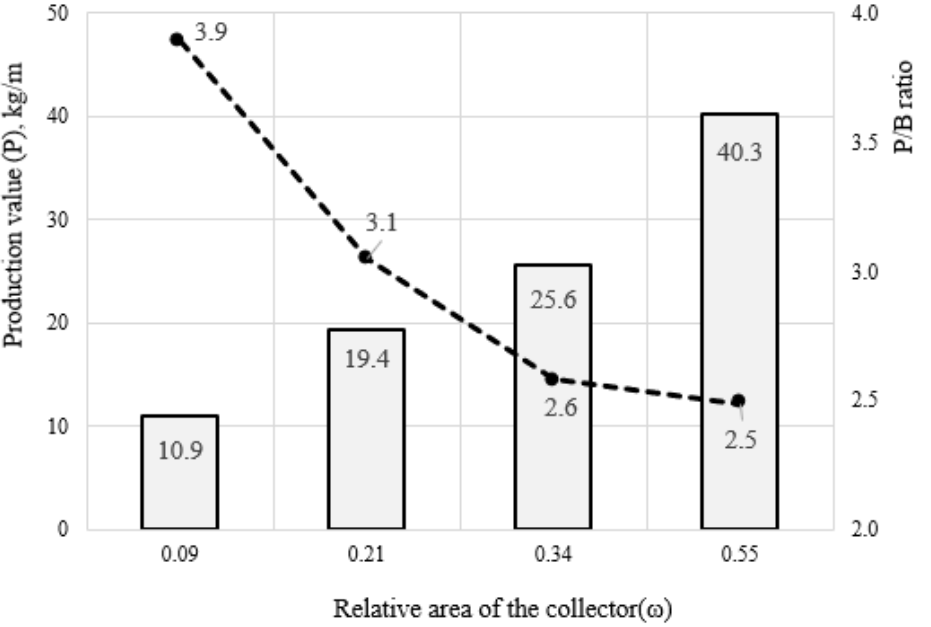
Figure 7. Change in the average production value (P, kg/m) and P/B ratio (dashed line) of mussel populations on various types of artificial substrates.